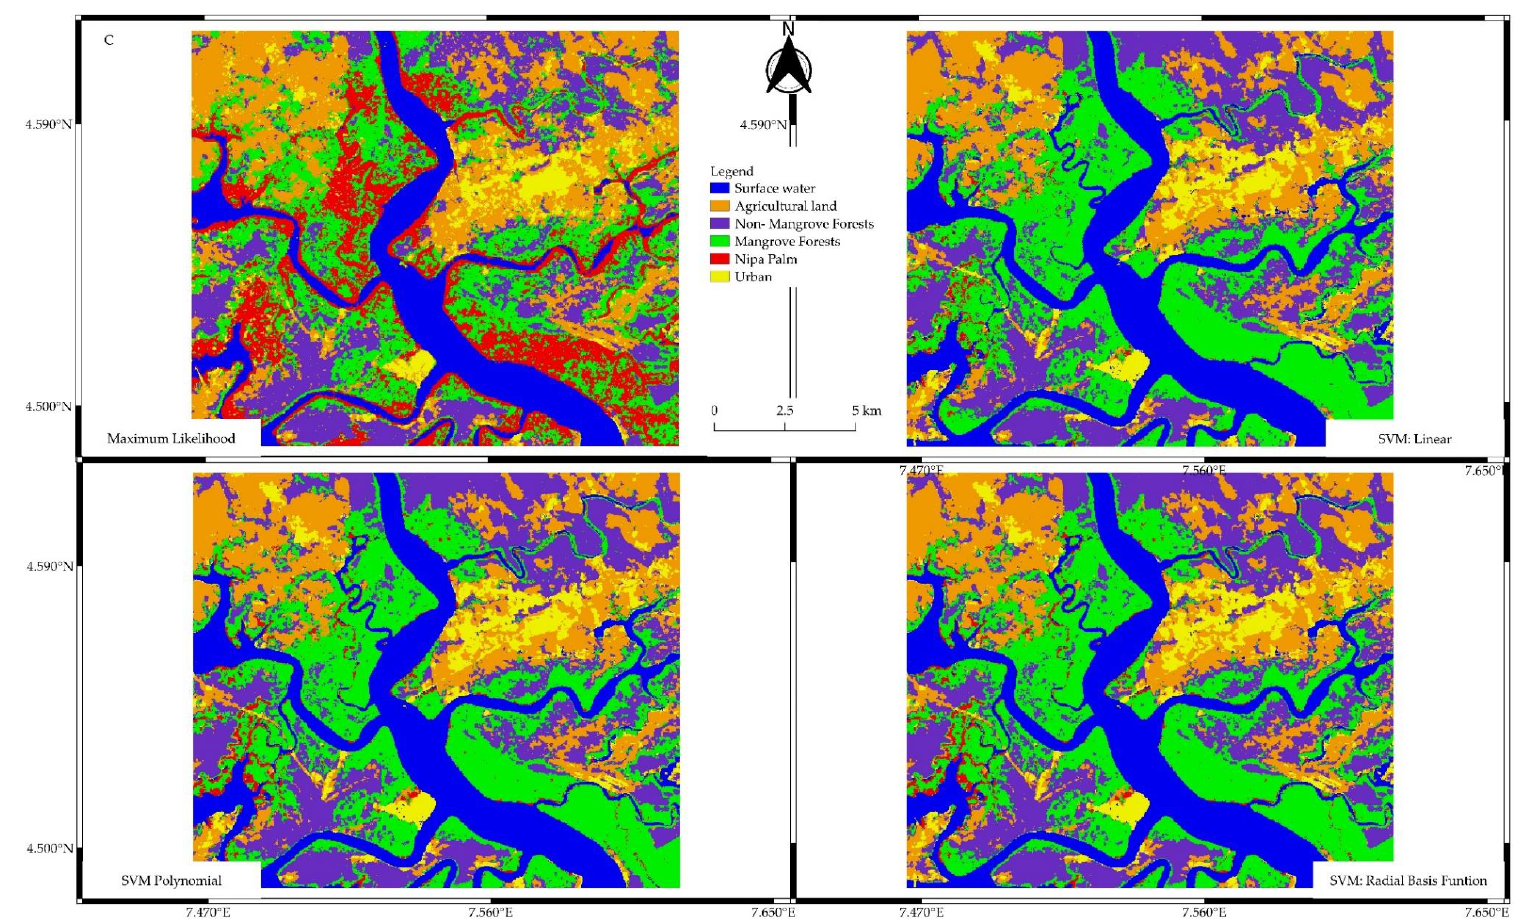
Figure 4. 2017 thematic map from Support Vector machine: Radial Basis Function kernel type ( i ) highlighting inset regions. Detailed analysis of the thematic maps produced by the di ff erent classifiers (Maximum Likelihood, Support Vector machine: Linear, Polynomial and Radial Basis Function kernel types) in three regions of the Niger Delta (Support Vector machine: Radial Basis Function): ( A ) Calabar Estuary; ( B ) Oproama Community and ( C ) Imo River Estuary.